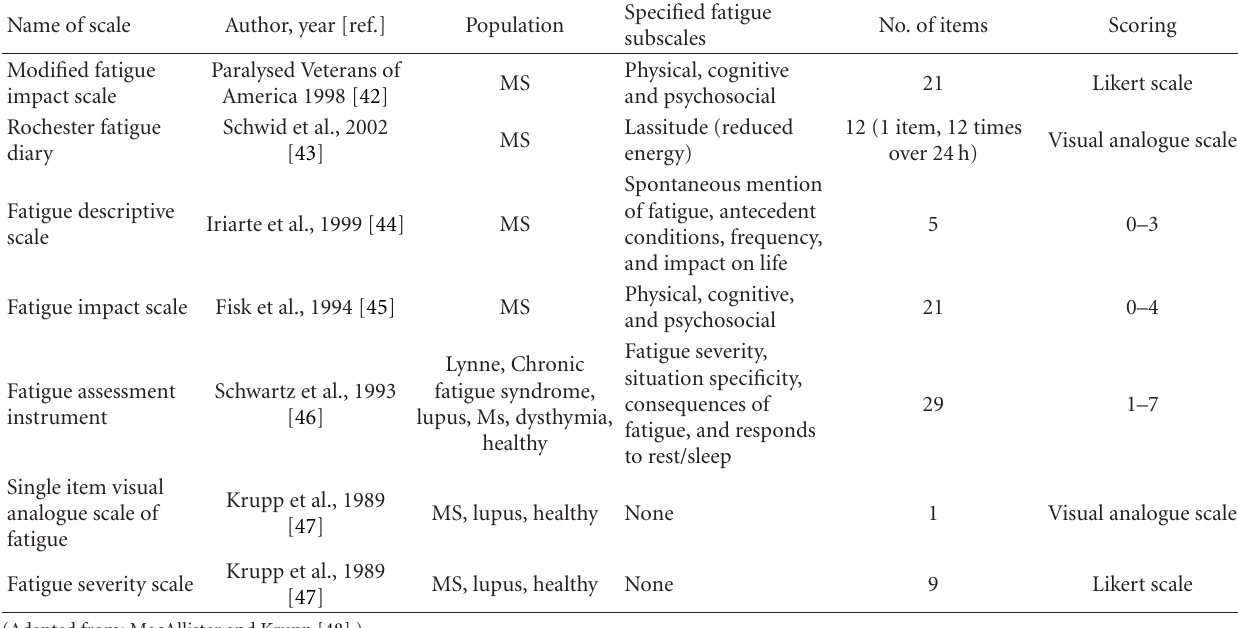
Table 6: Measures of multiple sclerosis related